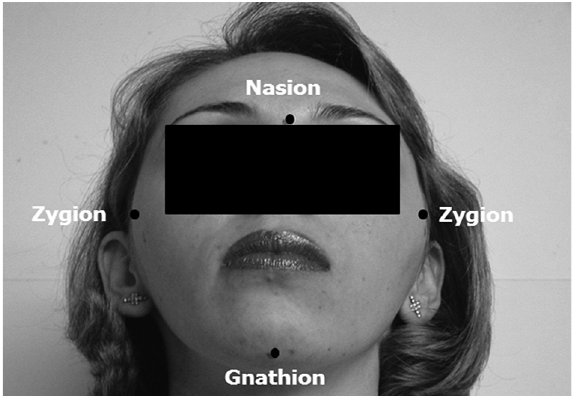
Figure 1. Craniometric points (nasion, gnathion and zygion).